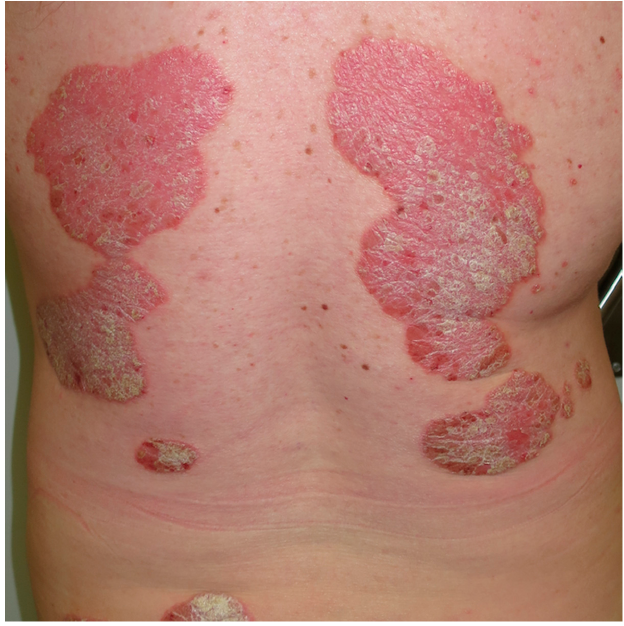
Figure 4. Psoriasis. Well demarcated, erythematous, scaly plaques that are relatively symmetrical on the back.